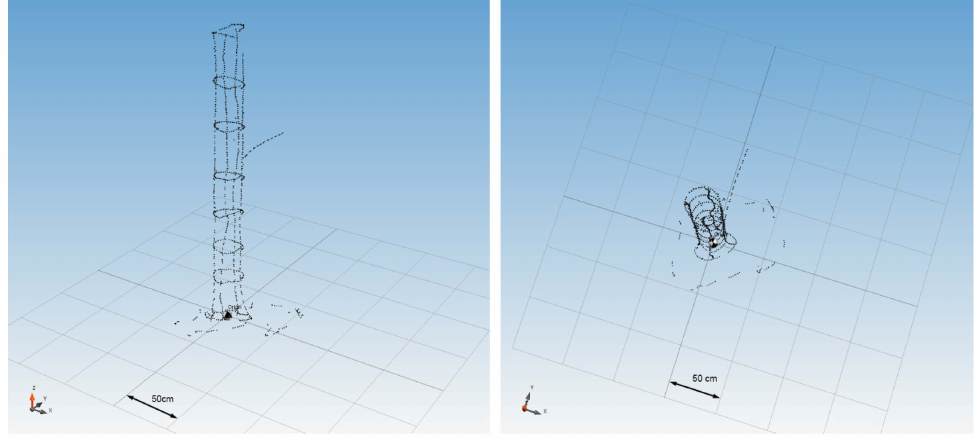
Figure 3. Surface data collected from a tree stem surface by a magnetic motion tracker.